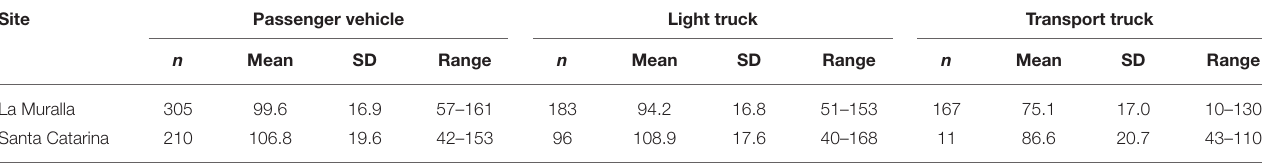
Posted speed limits were 60km/h at both sites.